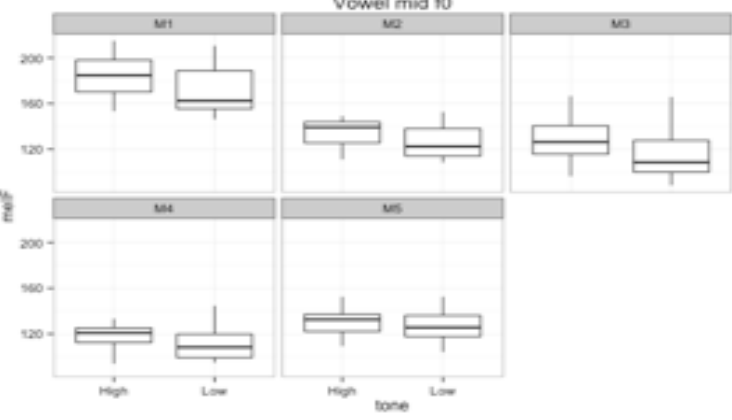
Figure 18: Speaker-wise distribution of the f0 values of the low tone and high tone vowels in the mid-vowel position (in